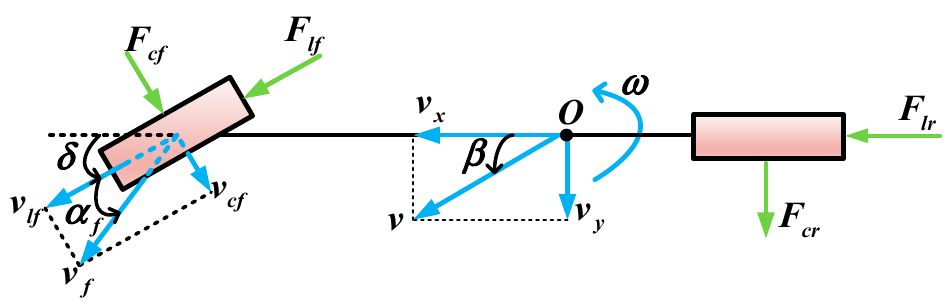
Figure 3. 2DOF vehicle dynamic model.